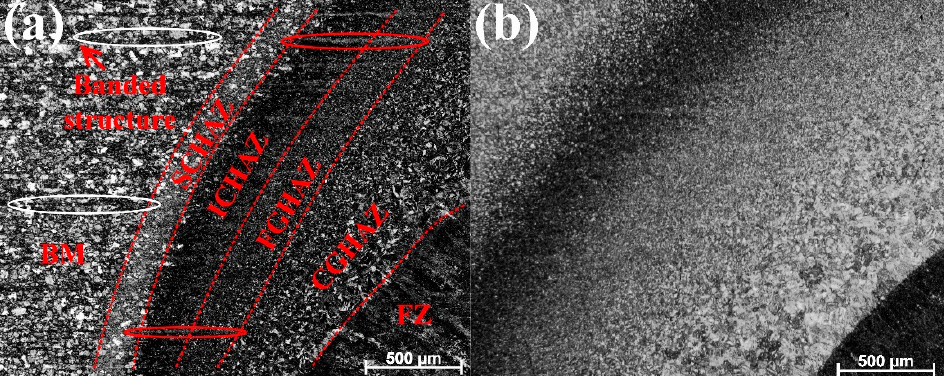
Figure 4. Microstructures of different zones within the welded joints: ( a ) ULCW joint; ( b ) UDW (underwater dry welding) joint.